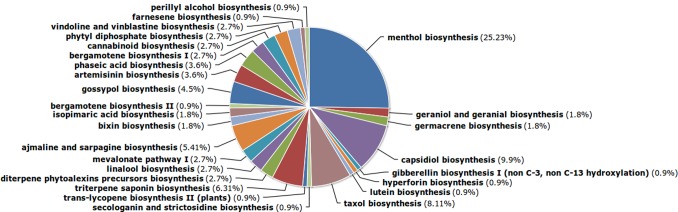
Terpenoid pathways represented in the PlantCyc annotation of the representative transcripts.